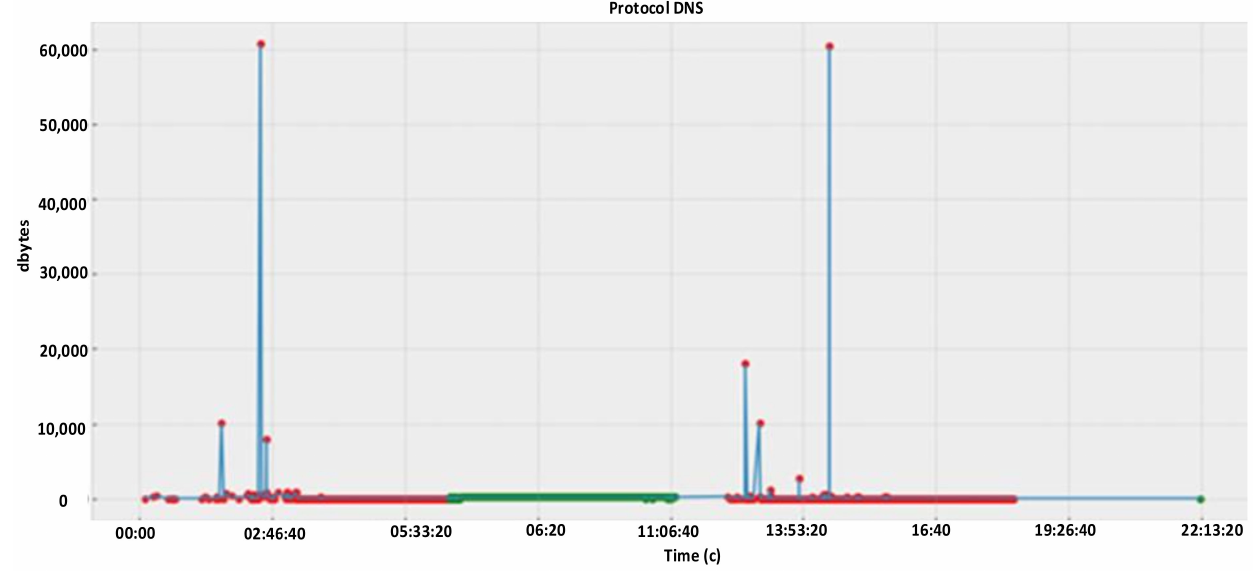
Figure 19. DNS protocol.